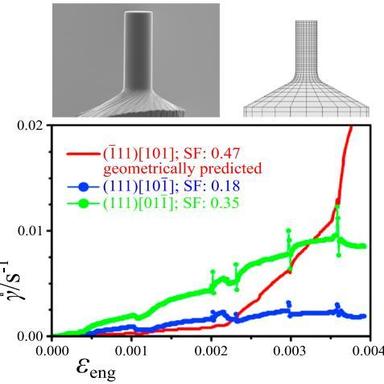
Nickel pillar compression: Initial pillar geometry from experiment and simulation (top). Average shear rates on the dominant slip systems as a function of the engineering strain (bottom); SF: SCHMID factor. Figure adopted from with permission from Elsevier.